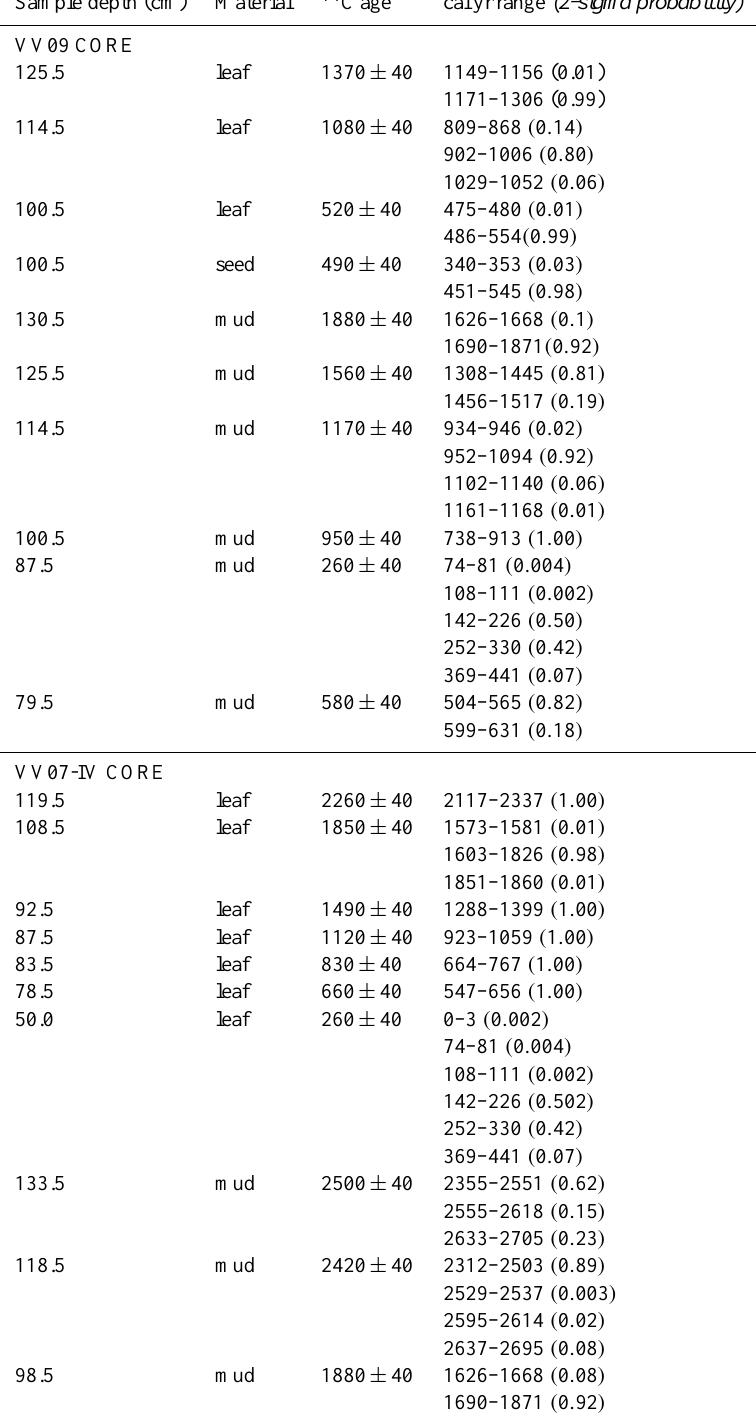
Table 1. Radiocarbon dates from the Verlorenvlei cores. Calendar year conversions (year before 1950AD) were calculated with CALIB 5.0.1, using the SHCal04 dataset (McCormac et al.,